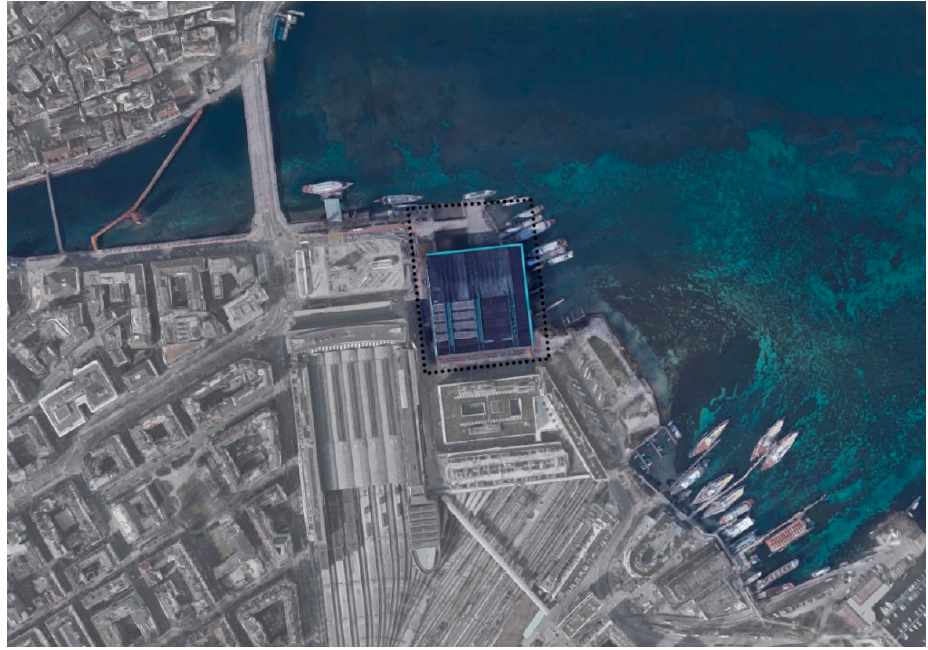
Figure 9. Context of Kultur- und Kongresszentrum Luzern, graphic processing, based on Google Maps by E. Latusek.